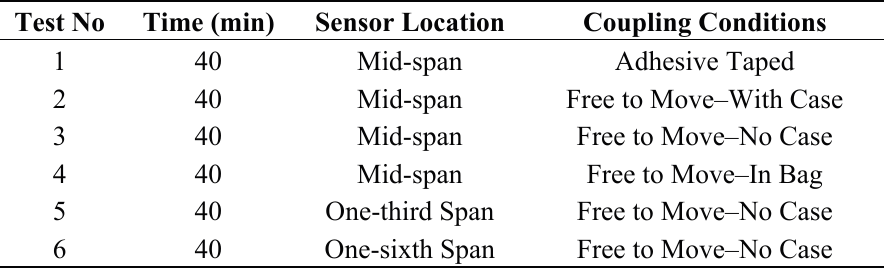
Table 2. Field measurement with different sensor locations and coupling